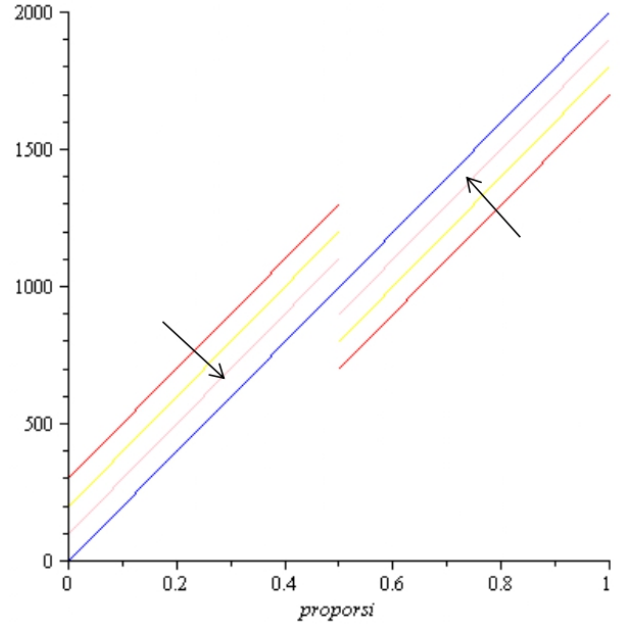
Figure 2. Graph of determining insurance premiums with a subsidy system.